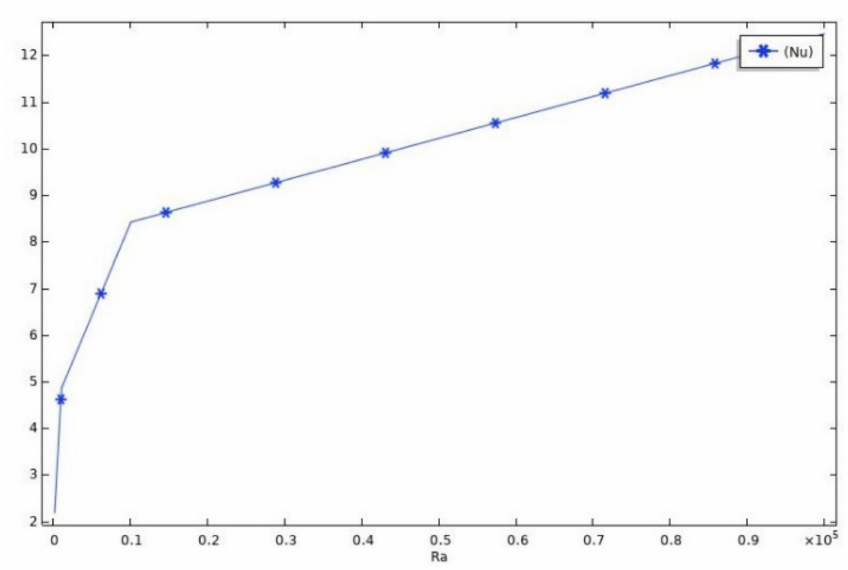
Figure 10. Nusselt number graph against varying ( Ra ) .